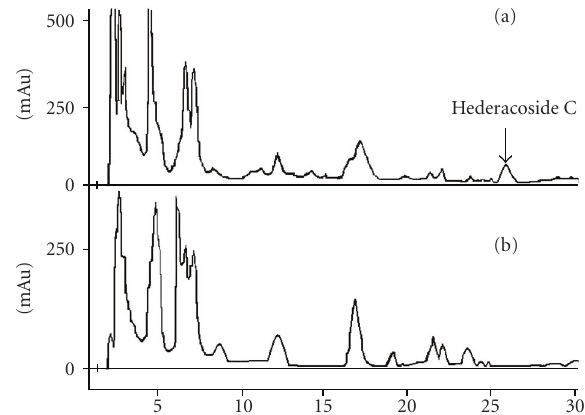
Figure 2: Liquid chromatograms of (a) Ivy-Thyme cough syrup sample and (b) Ivy-Thyme cough syrup placebo.